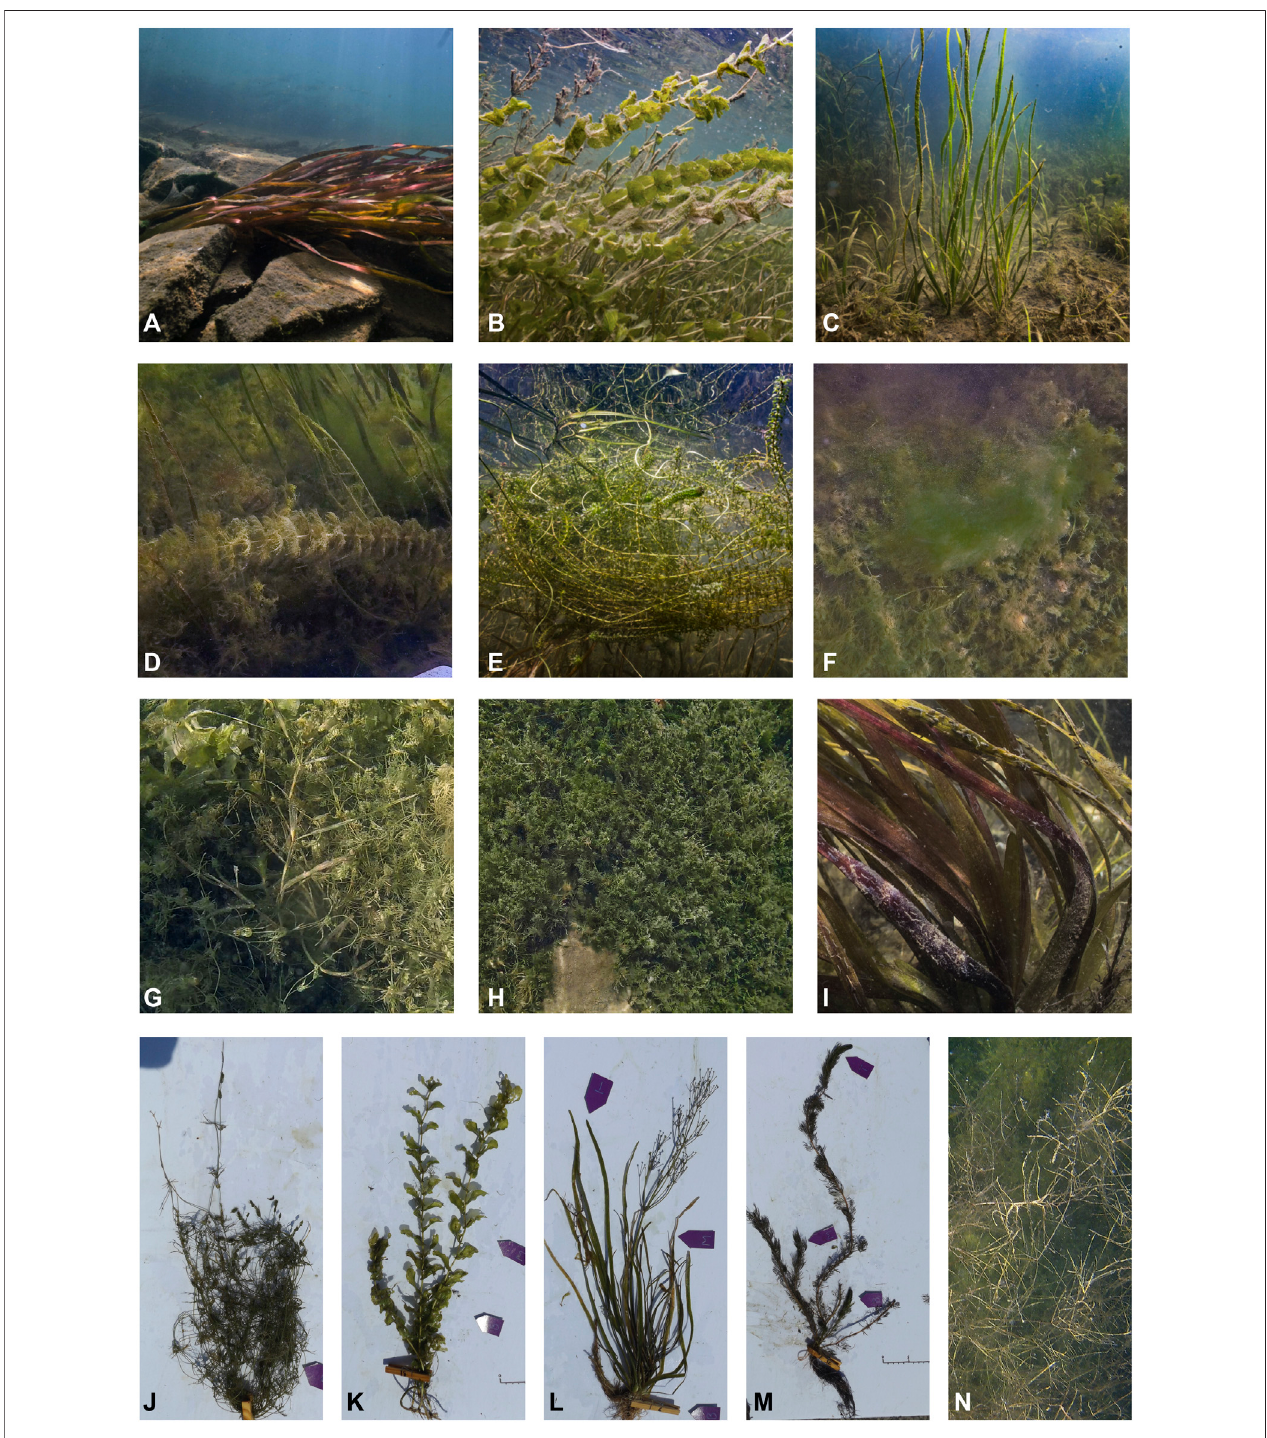
FIGURE2| Examplesofthevegetationencounteredatthesite (A-I) andexamplesofvegetationprovidedtoexpertinterpreters (J-N) . (A) Vallisneriaamericana ; (B) Potamogeton richardsonii ; (C) Sagittaria graminea ; (D) Myriophyllum spicatum ; (E) Elodea canadensis ; (F) Metaphyton; (G) Potamogeton robbinsii ; (H) Chara sp. ; (I) Vallisneria americana with heavy leaf fouling; (J) Chara sp. ; (K) Potamogeton richardsonii ; (L) Sagittaria graminea ; (M) Myriophyllum spicatum ; (N) Potamogeton sp. .